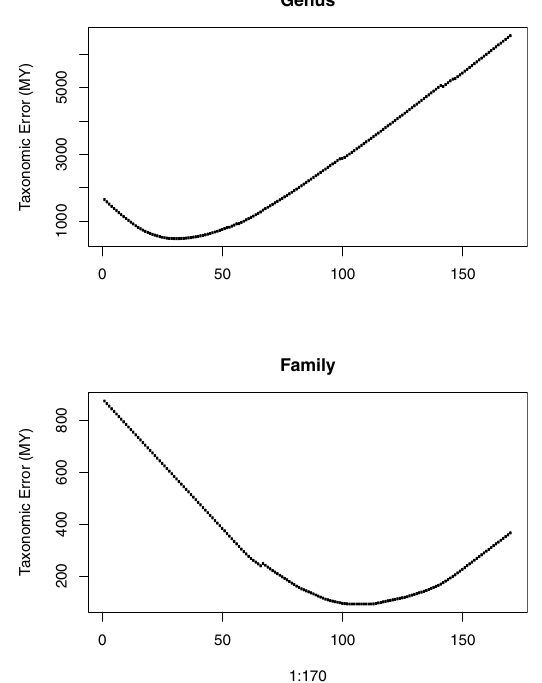
Figure 2. Distribution of empirical error score estimated from the tip (time = 0) to the root (the tree depth) for the genus level (A) and family level